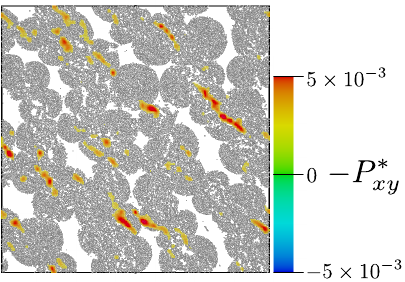
Figure 3. Evolution of the mean fragment size (cid:104) k (cid:105) against the shear strain γ for ˙ γ ∗ = 10 − 2 . 5 (solid line), 10 − 3 . 5 (dashed line), and 10 − 4 . 5 (dash-dotted line).